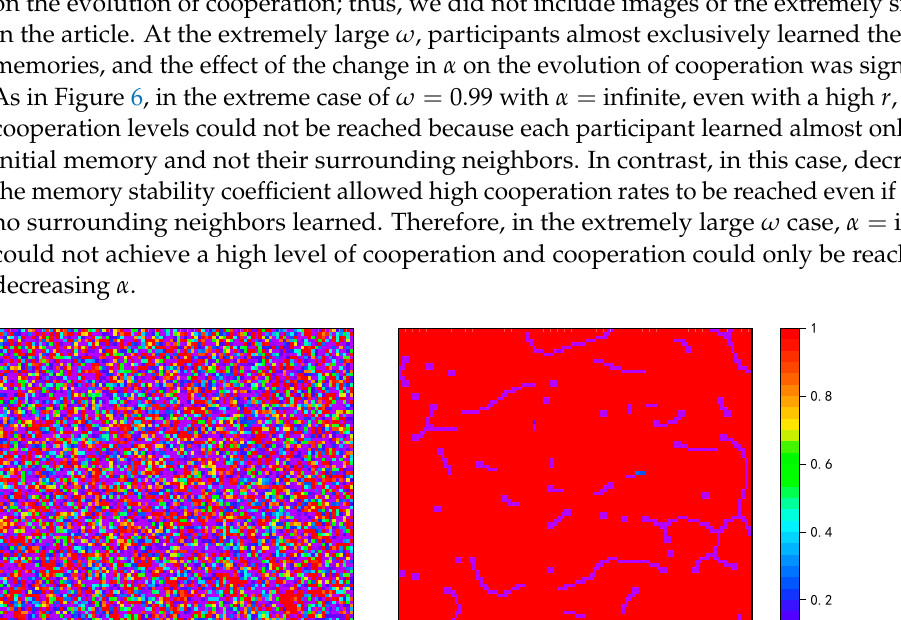
Figure 7. Relationships between population cooperation levels and the parameter (𝜔,𝑟) for differ- ent memory stability coefficients 𝛼 . ( a – f ) represent 𝛼 = infinite, 5, 4, 3, 2, 1, respectively. Color coding indicates the average cooperation level 𝜌 (cid:3030) , as shown on the right side of each graph. To explore the effect of the change in 𝛼 on the distribution of group strategies for different 𝑟 cases, we simulated three values of 𝛼 for 𝑟 = 2.0 and 𝑟 = 4.0 ,